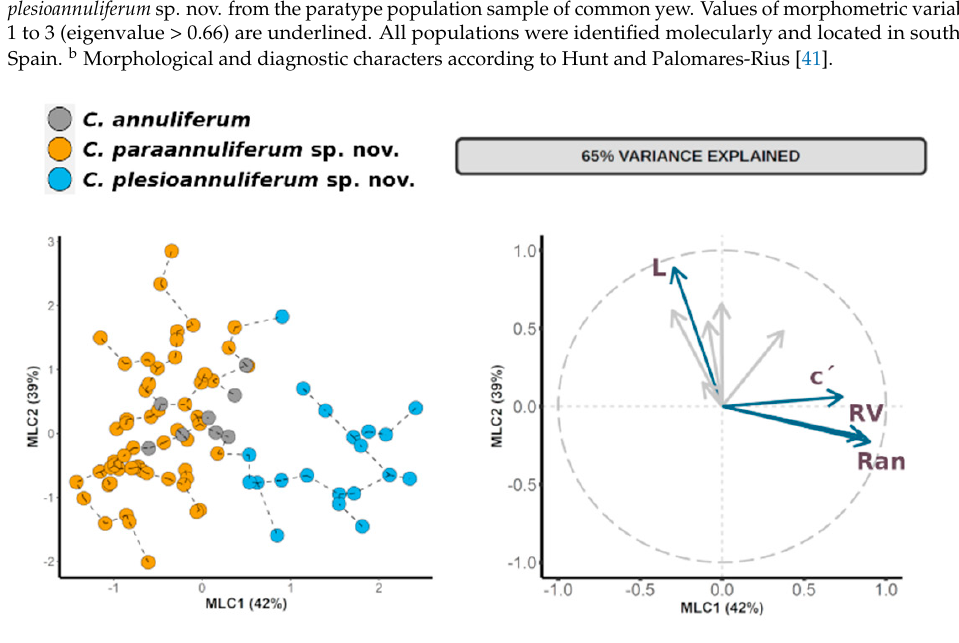
Figure 2. Principal component on morphometric characters to characterize Criconema annuliferum - complex species with a superimposed minimum spanning tree (based on Euclidean distance). Blue arrows indicate morphometric variables with projected eigenvalue > 0.70.